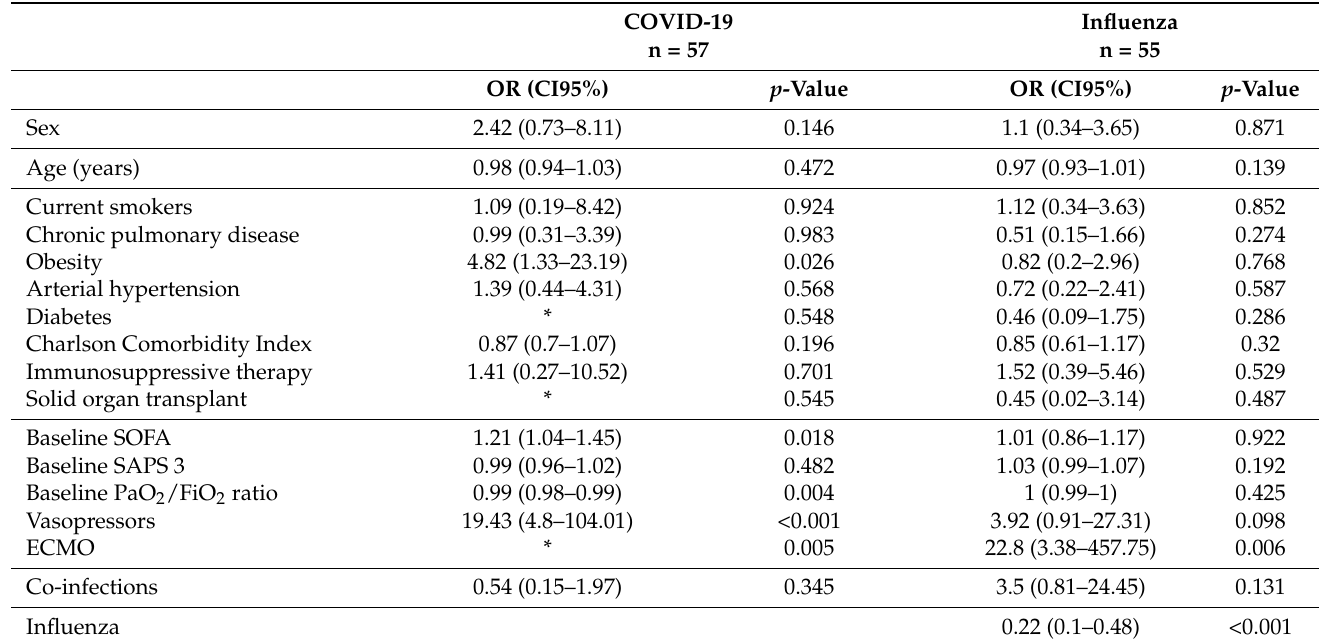
Table 5. Univariate analysis of the risk factors for secondary